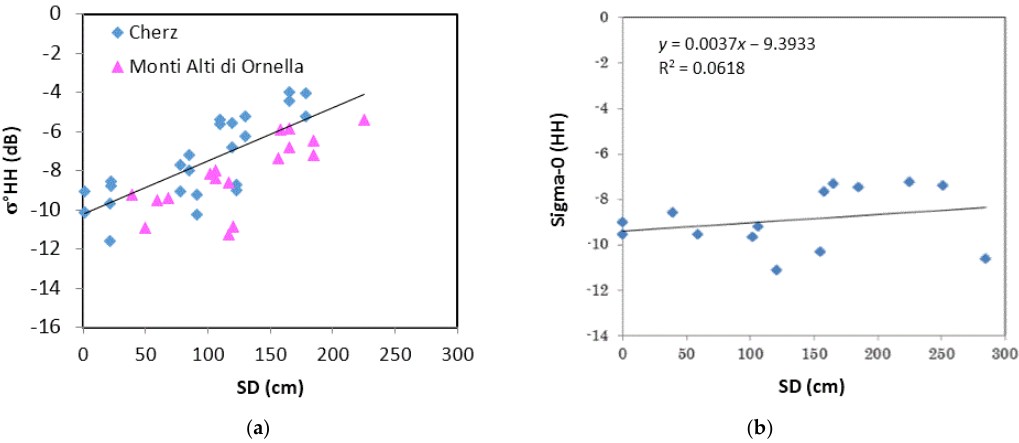
Figure 3. ( a ) σ ◦ at X band in HH polarization vs. SD collected in Cordevole basin (Cherz and Monti Alti di Ornella) during winter seasons, 2012–2013 and 2014–2015. The obtained regression line is σ ◦ = 0.027SD – 10.24 with R 2 = 0.65. ( b ) σ ◦ at X band in HH polarization vs. SD collected in Cordevole area during winter 2013–2014.